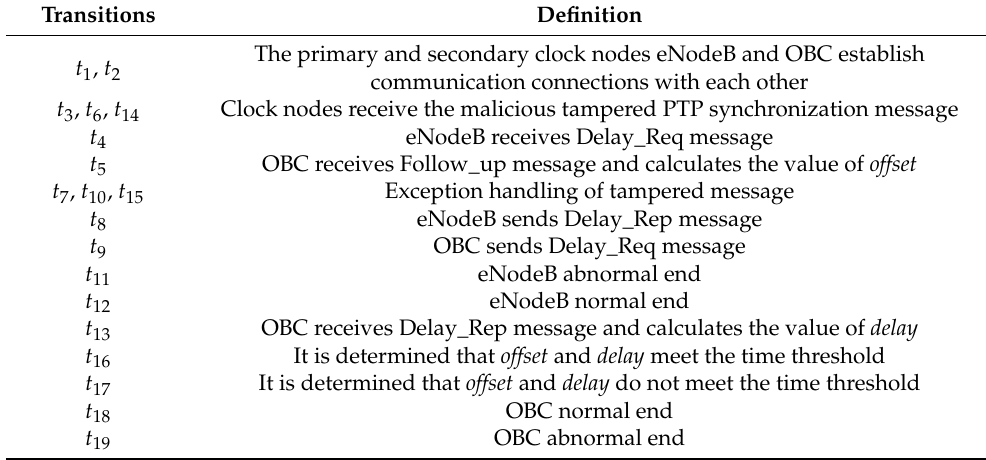
Table 2. Definitions of